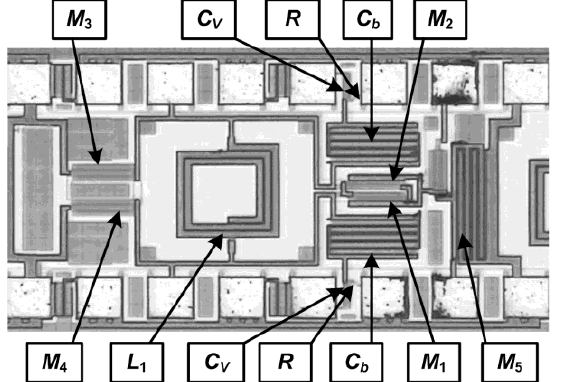
Figure 6. Photomicrograph of the fabricated 2.4 GHz direct-modulation